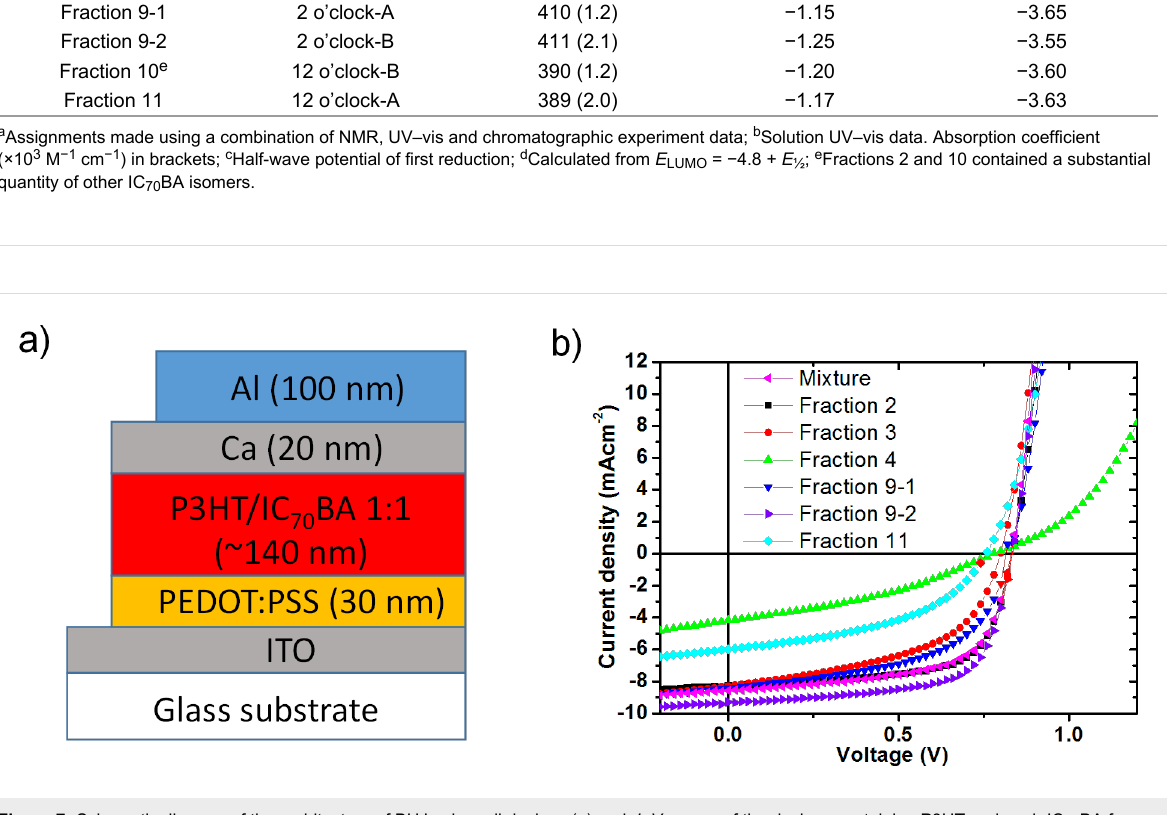
Figure 7: Schematic diagram of the architecture of BHJ solar cell devices (a) and J − V curves of the devices containing P3HT and each IC 70 BA frac- tions (b).